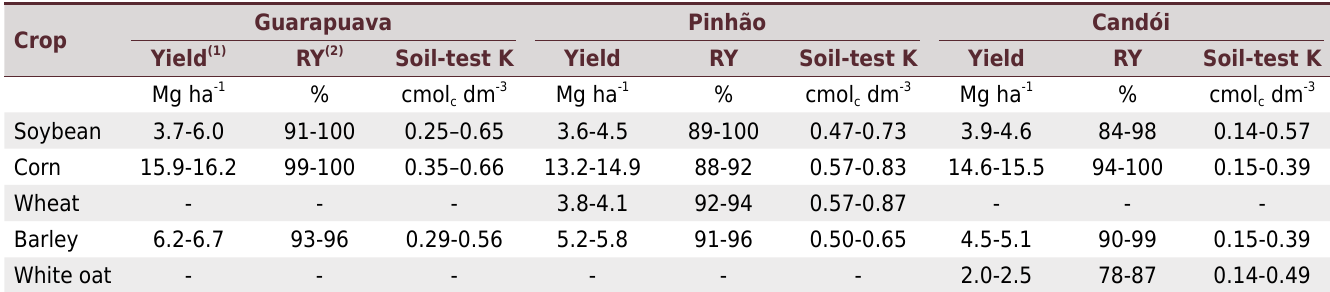
Table 1. Grain yield range and relative grain yield (RY) for soybean, corn, wheat, barley, and white oat, and soil-test K value (Mehlich-1, 0.00-0.20 m layer), as obtained in calibration experiments with different K 2 O rates applied in